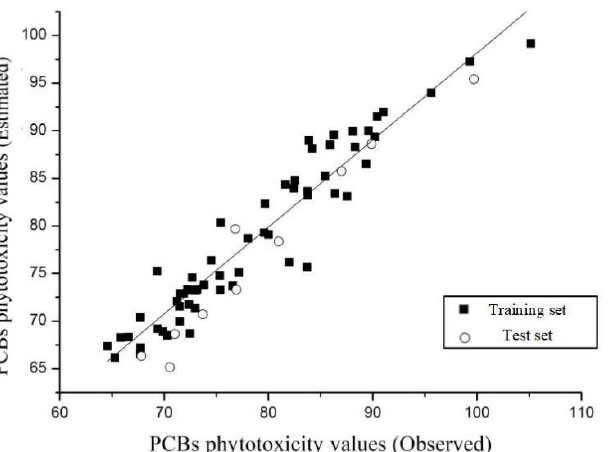
Figure 2. The plot of the observed vs. estimated phytotoxicity values of PCBs by using the 3D-QSAR models.